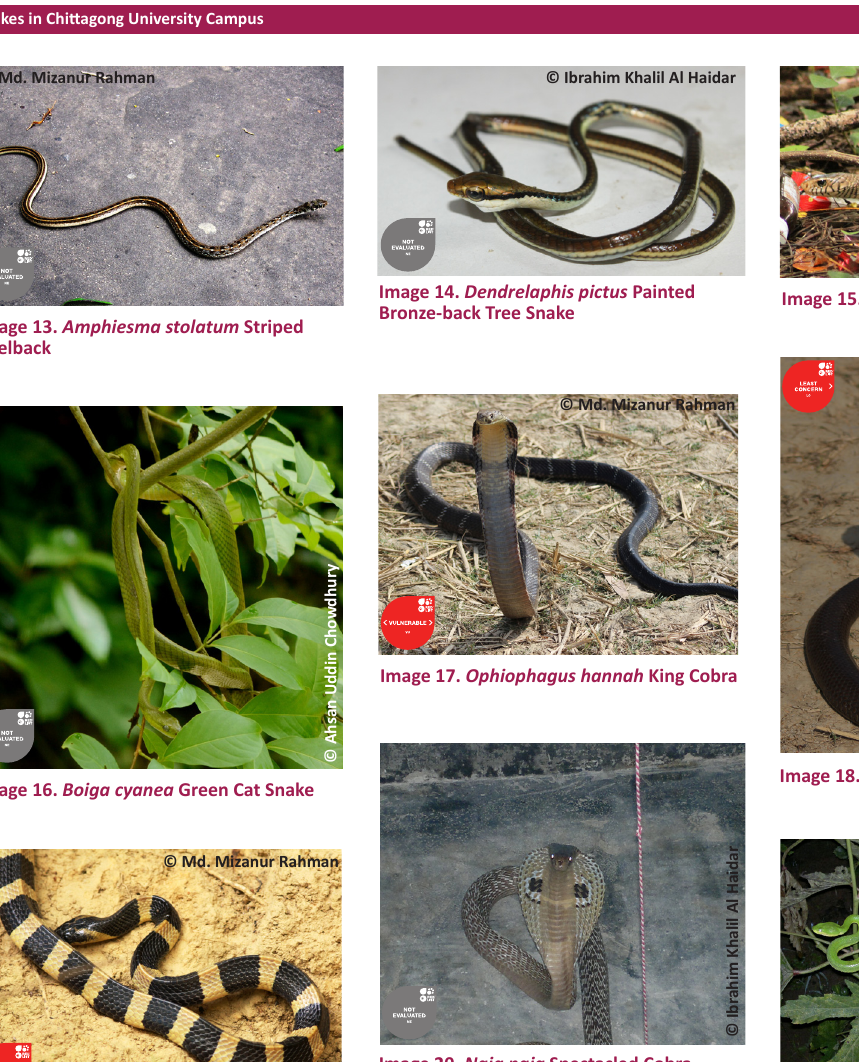
ViperImage 20. Naja naja Spectacled